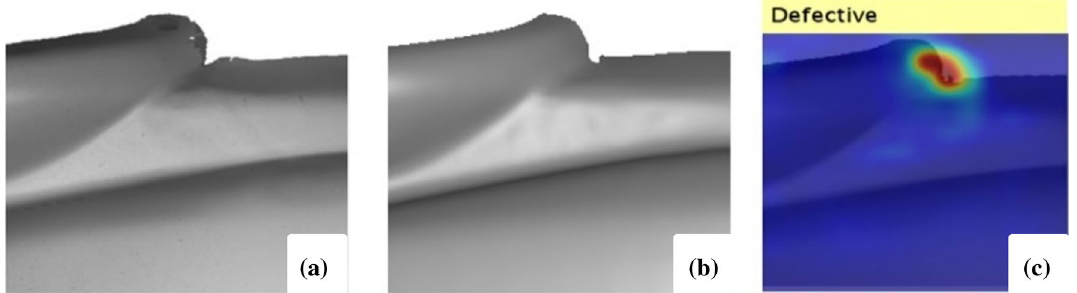
Fig. 9 Comparison of correctly and misidentified test parts according to DNN training method with a scan image, b simulation image, c DNN heatmap defect